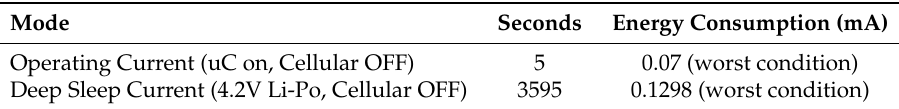
Table 9. Particle electron energy consumption in critical